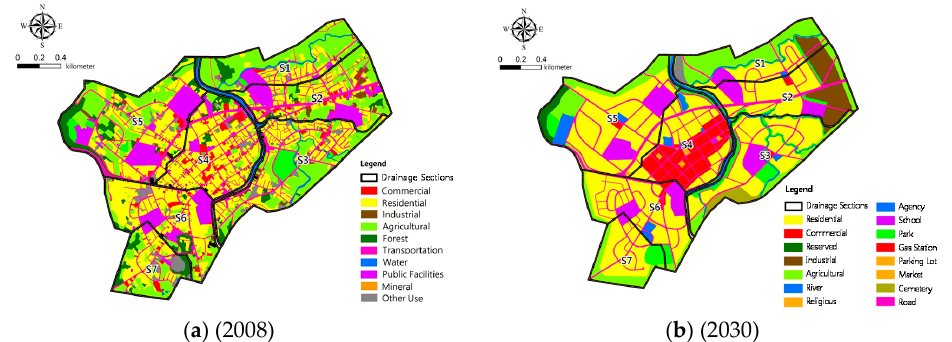
Figure 7. Present and future land-uses on city scale: ( a ) present; ( b ) future.